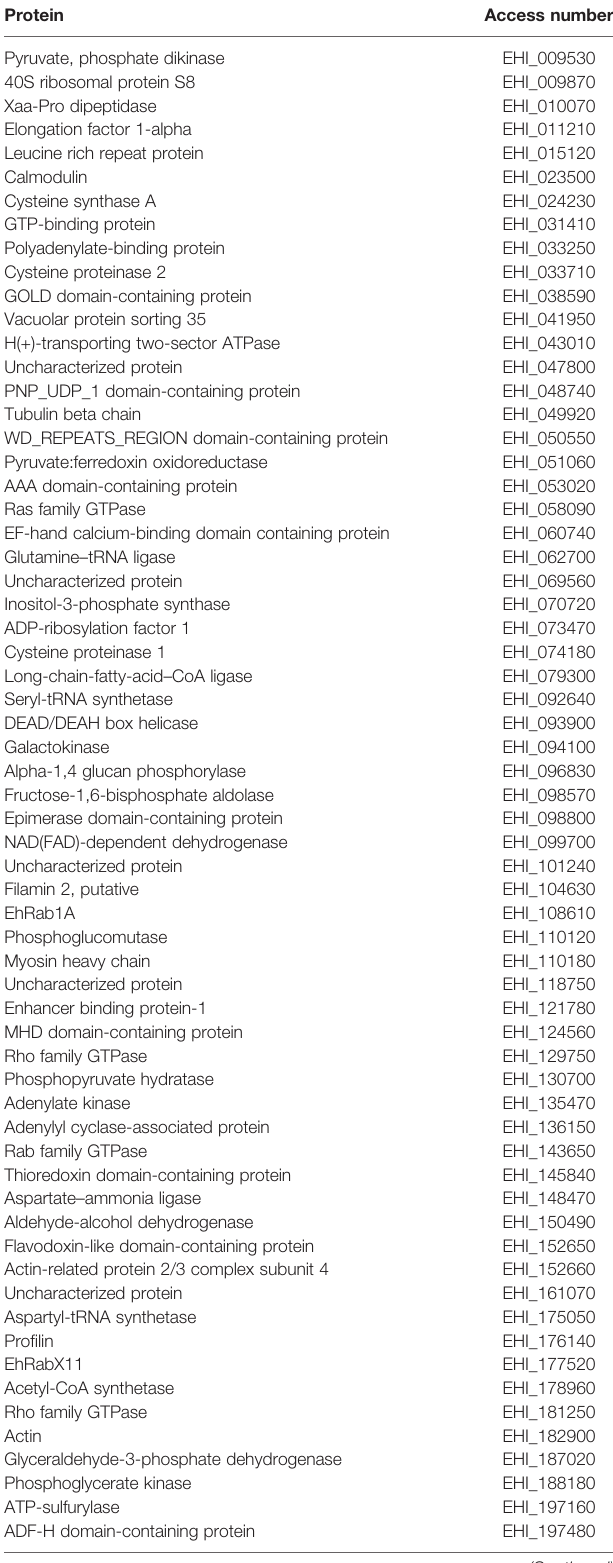
TABLE 4 | Proteins associated with secretion***. Protein Access number